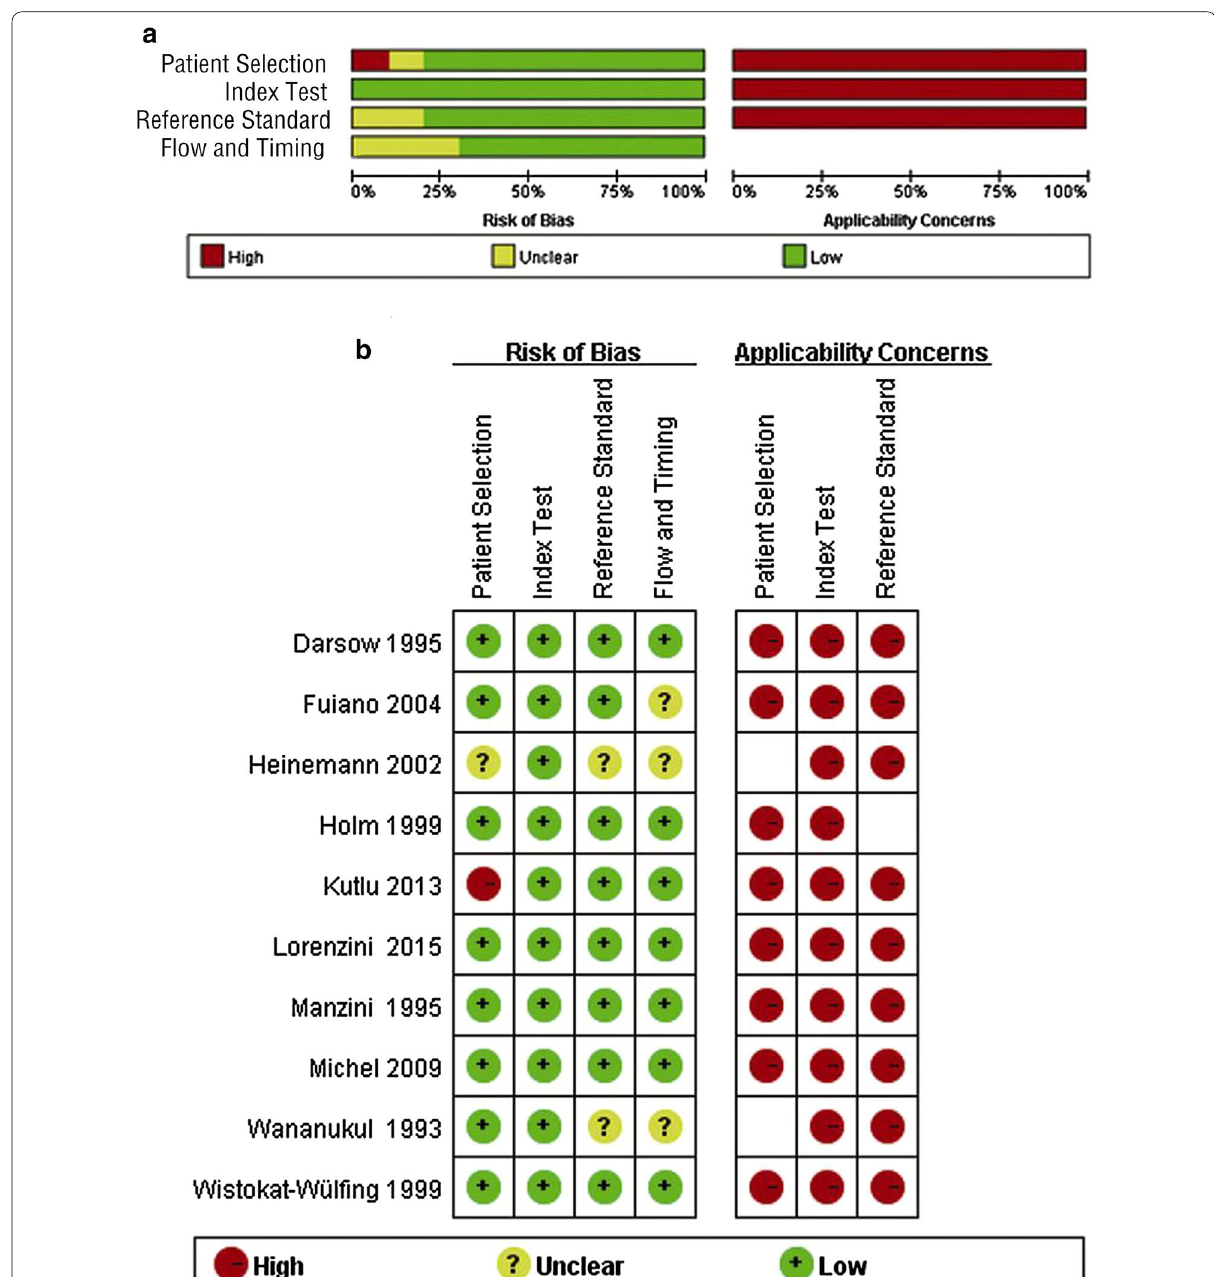
Fig. 2 Cumulative bar plot ( a ) and summary table ( b ) of risk of bias and applicability concerns across all